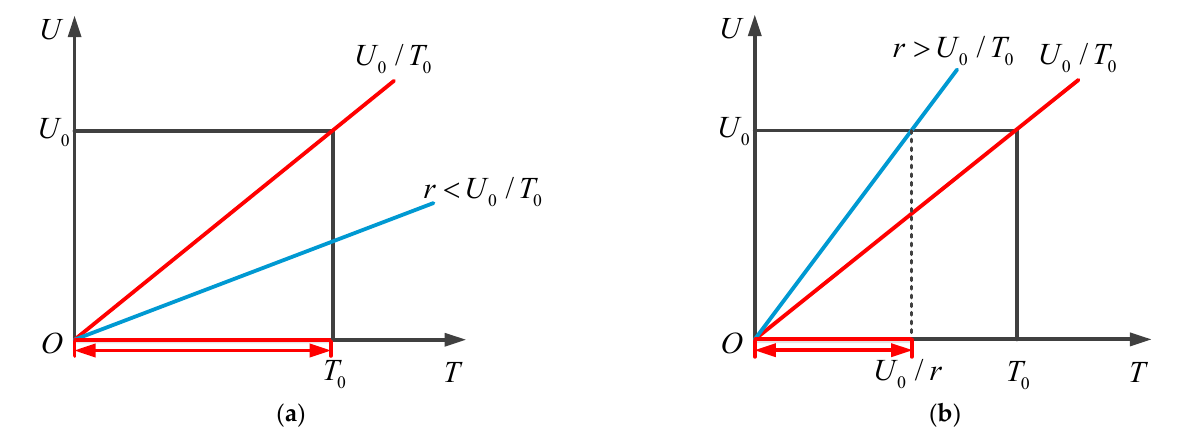
Figure 2. The real replacement time of a system. ( a ) r ≤ U 0 / T 0 , ( b ) r > U 0 / T 0 . Red line: Nominal utilization rate; Blue line: Actual utilization rate.